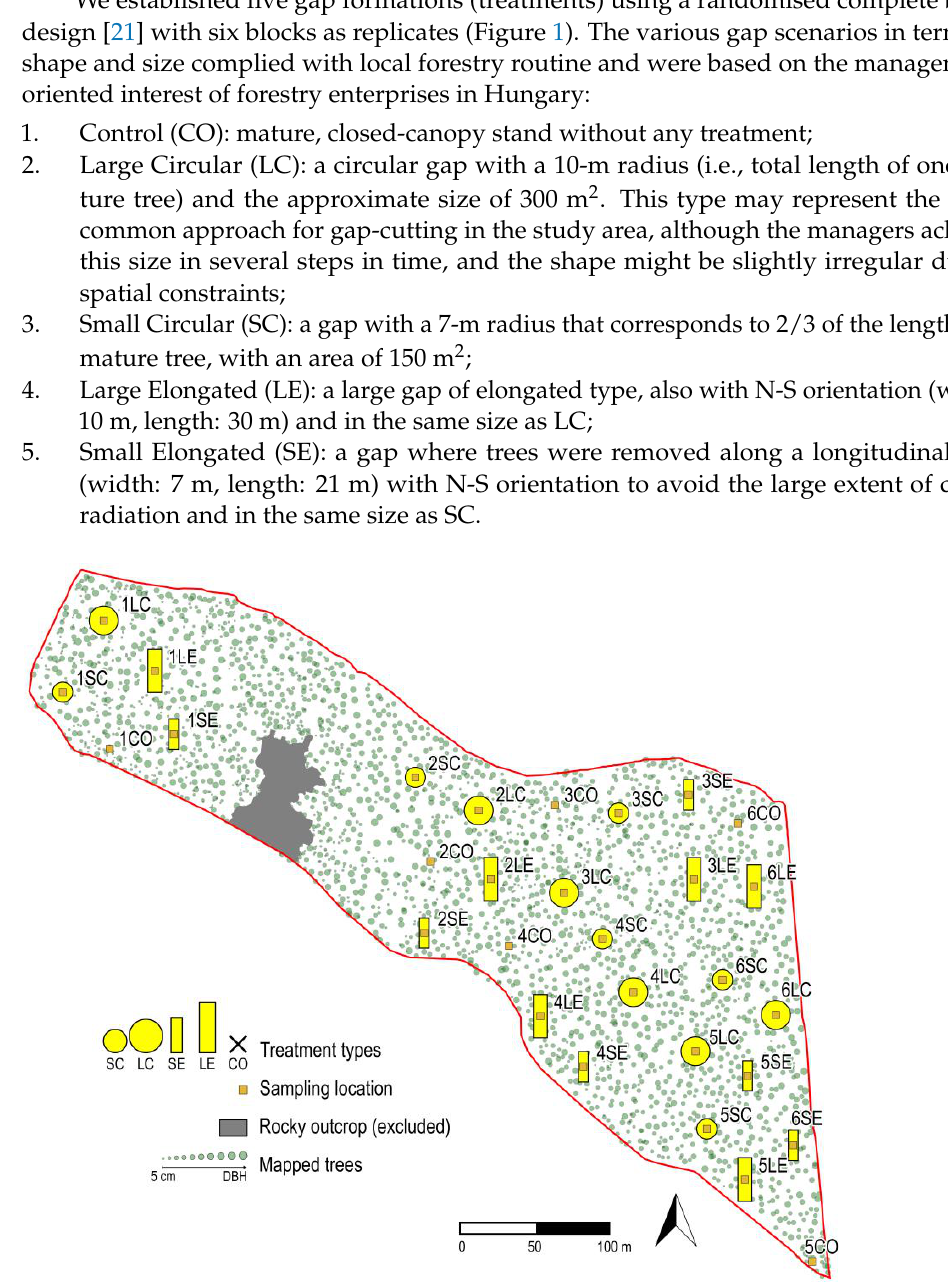
Figure 1. Design of the gap experiment in the experimental forest stand in the Pilis Mountains. Green dots indicate trees, with dot size relative to the diameter of the trunk at breast height (DBH). Yellow circles and rectangles show the positions and types of gaps created. We investigated two gap sizes (150 and 300 m 2 ) and two gap shapes (circular and elongated). Notation of the gap treatments is the following: SC = small circular, LC = large circular, SE = small elongated, LE = large elongated. Small rectangles indicate sampling locations in the centre of the gaps, where pitfall traps were placed in a triangular formation. Rectangles outside gaps show the sampling locations for control plots (CO). Numbering of plot nametags refers to which block they belong to.